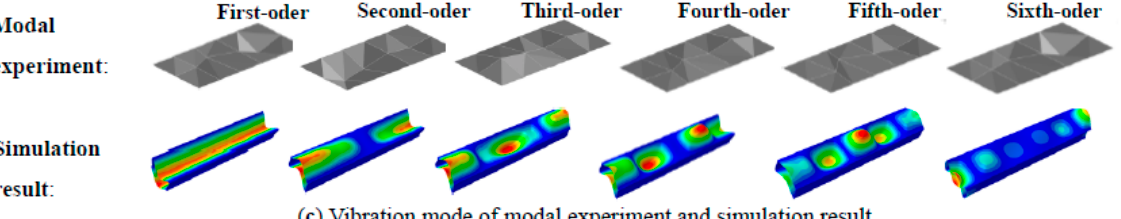
Figure 4. Printed XLS channel and vibration validation: ( a ) Experimental samples of XLS; ( b ) Model experiment value and calculated value; and ( c ) Vibration mode of modal experiment and simulation result .